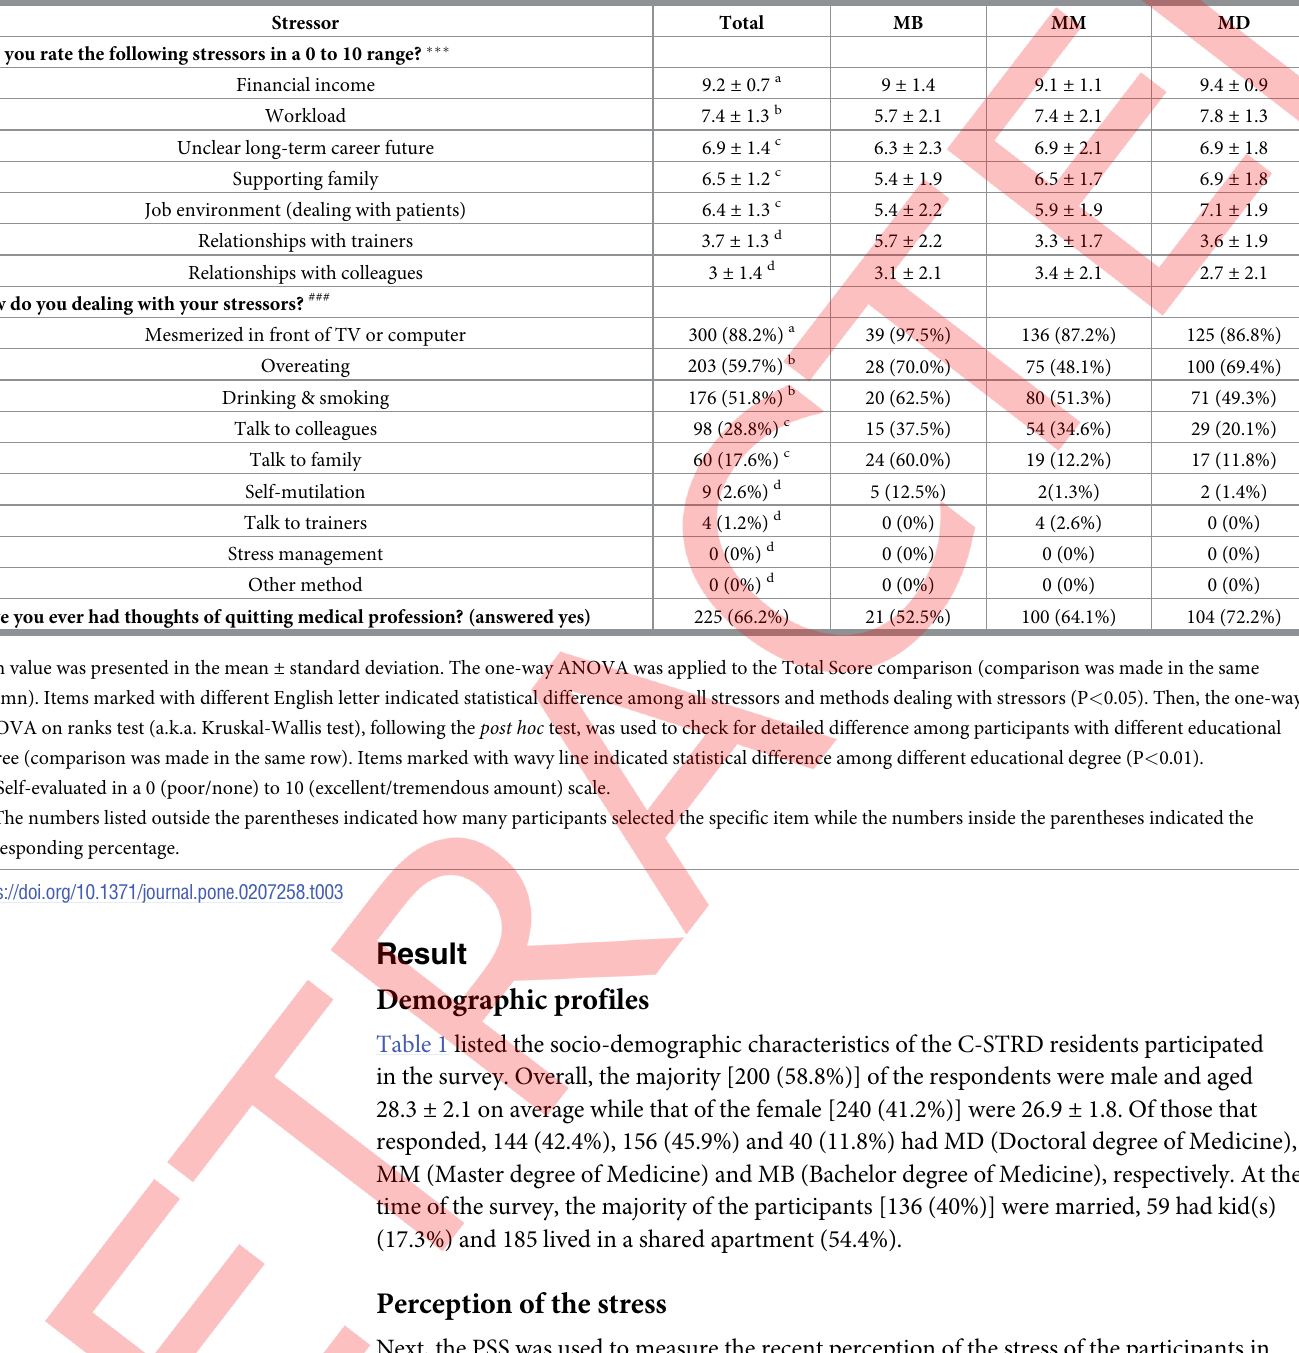
Next, the PSS was used to measure the recent perception of the stress of the participants in Table 2. All residents scored 27.3 ± 4.9 on average (ranged from 11 to 40). Specifically, the PSS score for the MB, MM, and MD residents were 26.6 ± 4.1, 27.8 ± 3.5 and 27.1 ± 5.2, respec- tively, and no significant difference was observed among them (P > 0.05). The top three causes resulted in this constant stress were that the participants “very often felt nervous and stressed” (PSS score 3.35 ± 0.65), their “things were very often out of control” (2.92 ± 0.27) and “they were never on top of things” (2.84 ± 0.26).